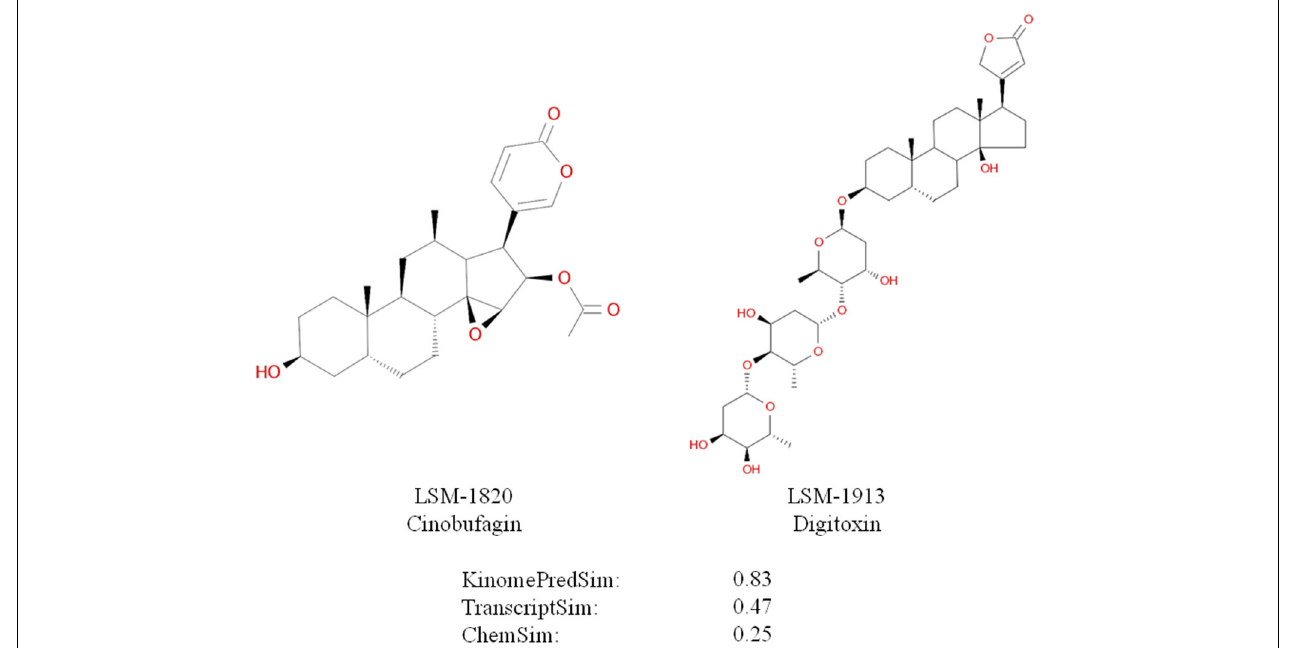
FIGURE 12 | Dissimilar compounds with high KinomePredSim and high TranscriptSim (based on L1000 in A549